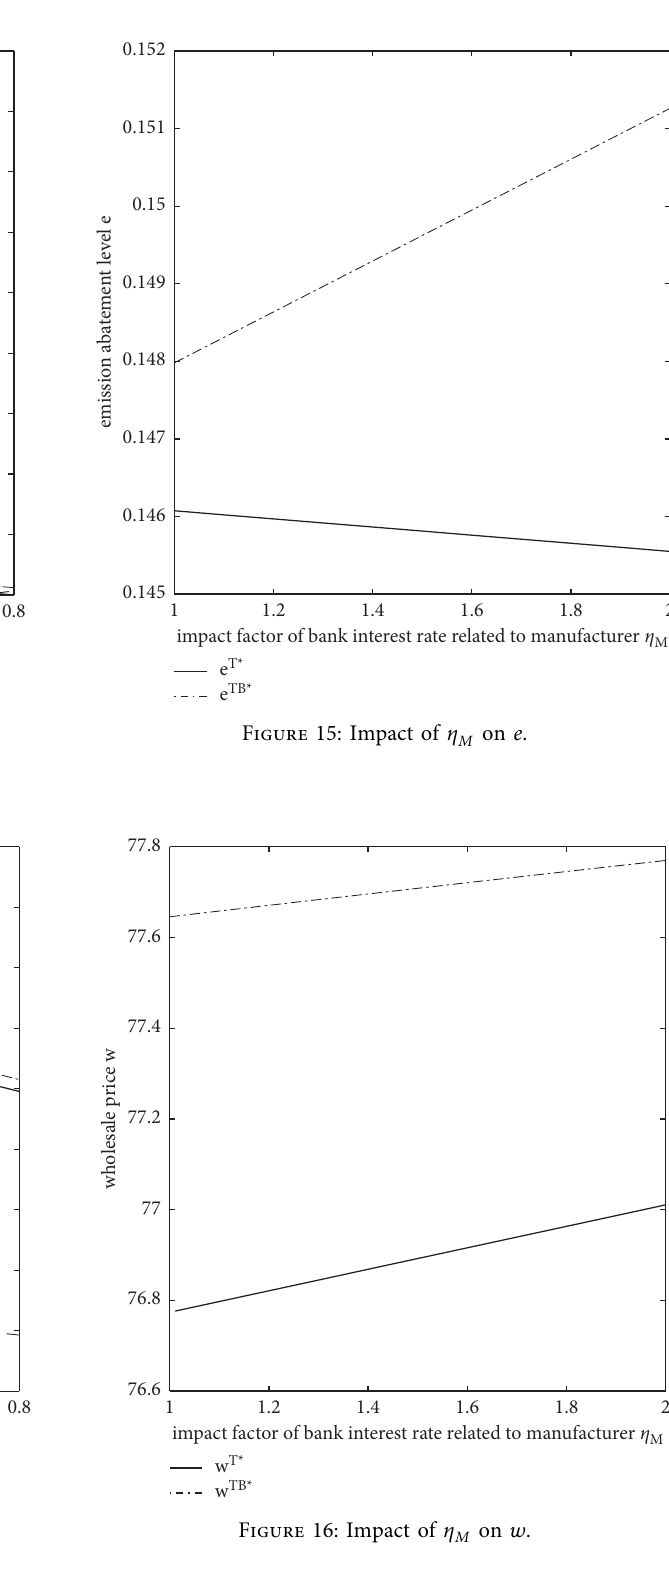
Figure 14: Impact of ϕ on π